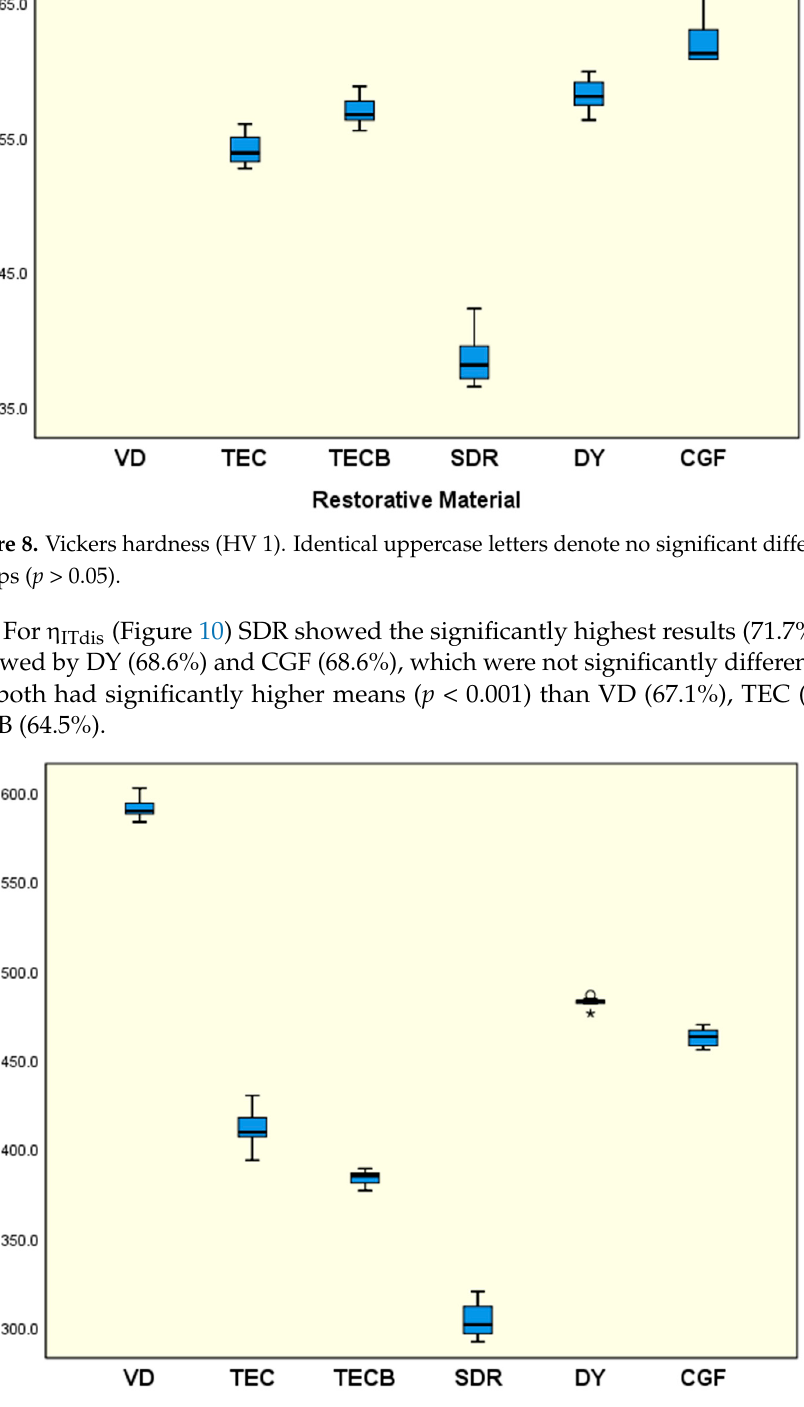
Figure 9. Martens hardness (N/mm 2 ). All calculated means are significantly different ( p < 0.001). Circles represent mild outliers (< 3.0 × interquartile range) and asterisks extreme outliers (> 3.0 × interquartile range).